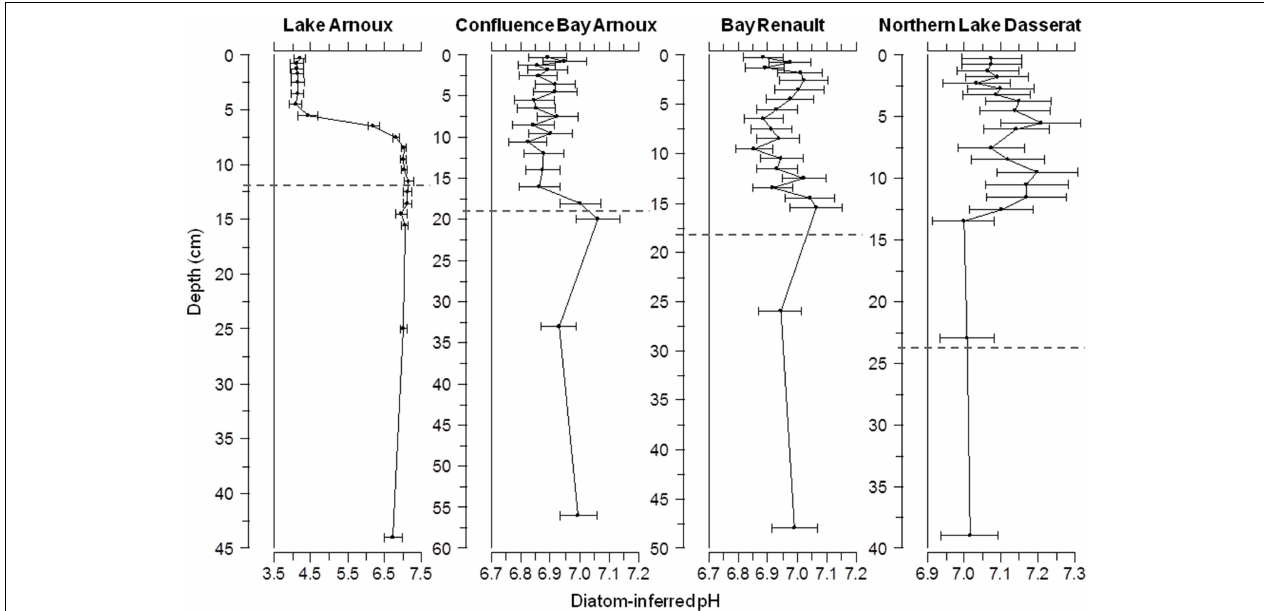
FIGURE 9 | Profiles of diatom-inferred pH-values for Lake Arnoux, Confluence Bay Arnoux, Bay Renault and Northern Lake Dasserat. The dotted line corresponds to the pre-mining period based on sedimentation rates determined with 210 Pb data.